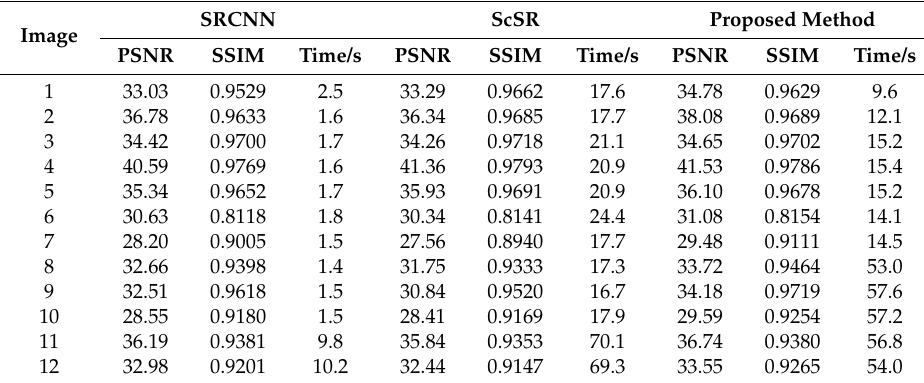
Table 1. SR results with upscaling factor of 2.